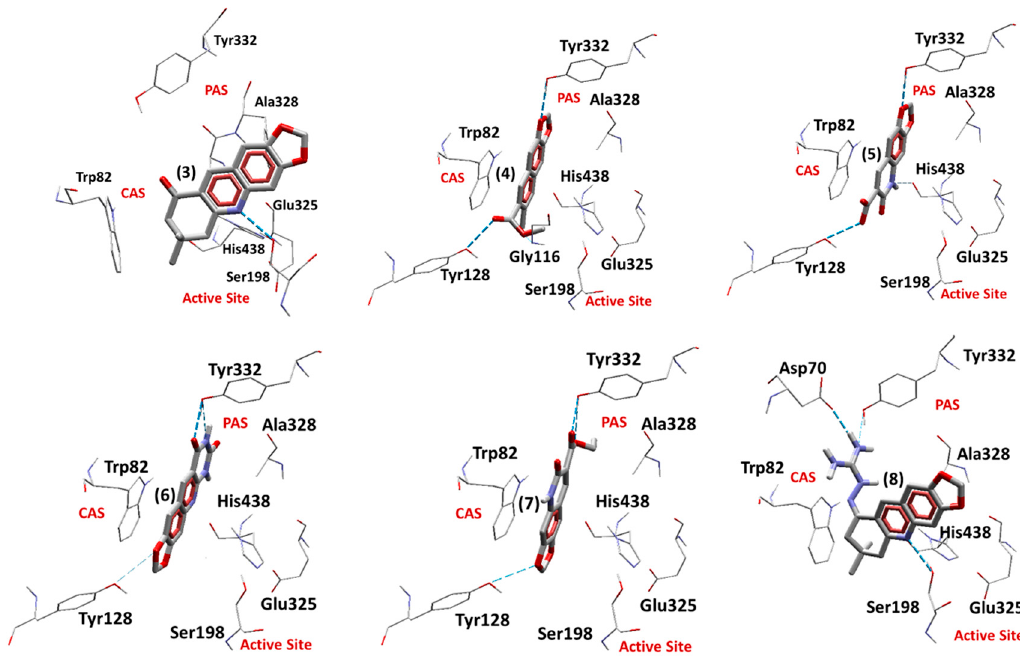
Figure 5. Best docking poses of the ligands inside EqBChE.